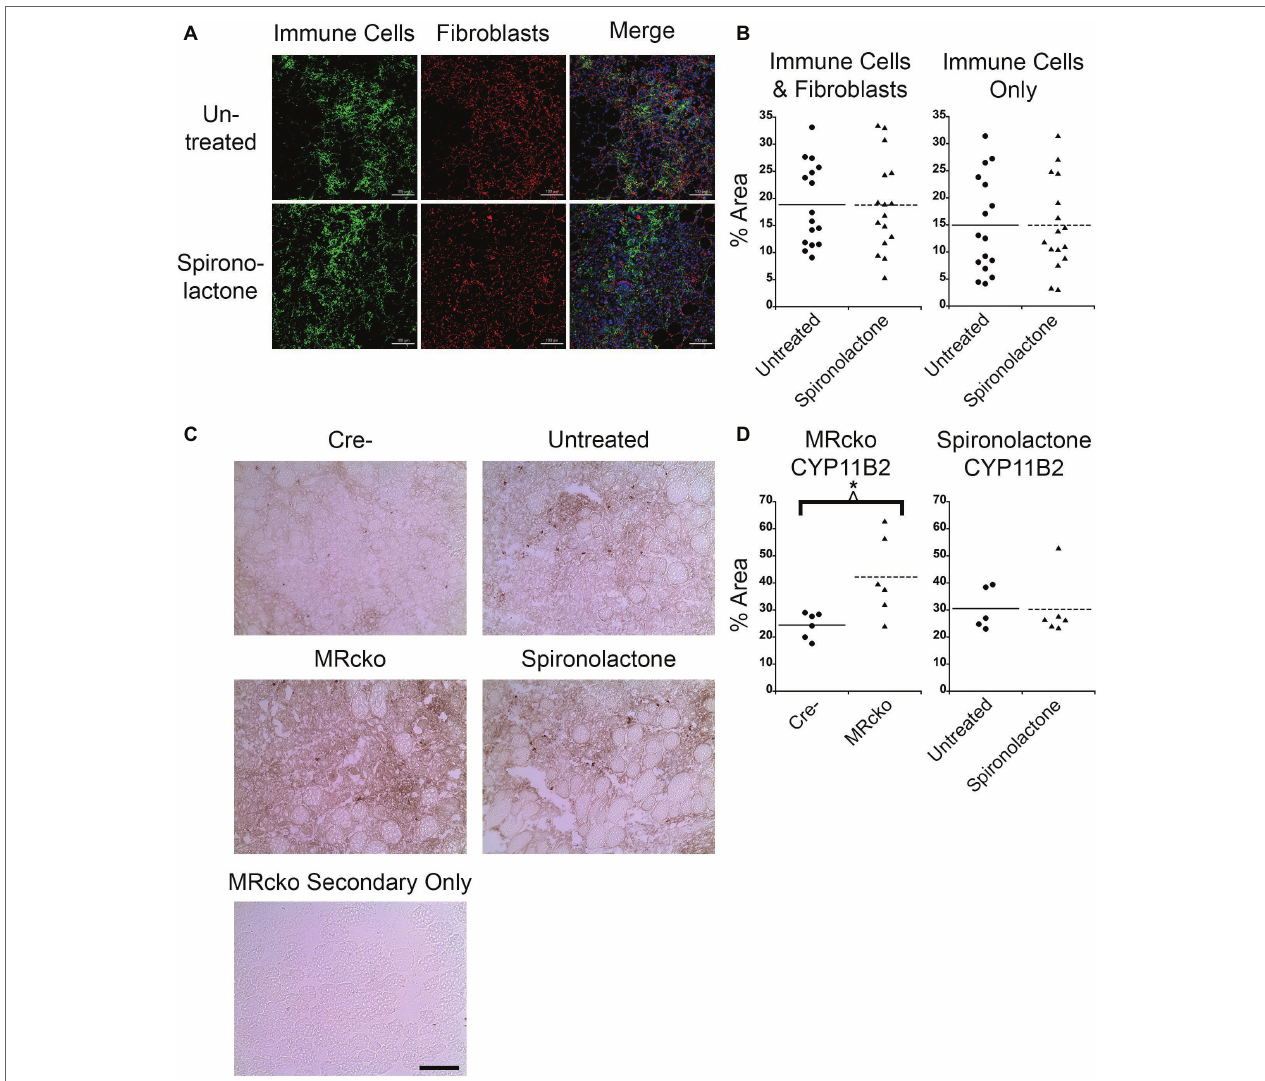
FIGURE 5 | MRcko mice have increased CYP11B2 infiltration at 4 days post-injury. (A) Acutely injured tibialis anterior (TA) muscles of spironolactone treated and untreated mice at 4 days after acute injury were stained for CD11b to visualize myeloid immune cells (green), vimentin to visualize fibroblasts (red), and with DAPI to visualize nuclei (blue in merged image) and were imaged with confocal microscopy. Zoomed out images are shown to depict the areas of muscle infiltrated by immune cells (green dots) or fibroblasts (red dots) quantified in B. Scale bar = 100 μ m. (B) Dot plots of spironolactone treated and untreated mouse ( n = 16 spironolactone, and 16 untreated) TA muscle percent area at 4 days post-injury of immune cells and fibroblast infiltration together or percentage of myeloid immune cells infiltration alone. Means are shown by lines for each group in the dot plots. (C) CYP11B2 immunohistochemistry was analyzed at 4 ( n = 6 Cre − , and 6 MRcko) ( n = 5 untreated, and 6 spironolactone) days post-injury. Scale bar = 100 μ m. (D) Dot plots of CYP11B2 percent infiltration at 4 days post-injury. Means are shown by lines for each group in the dot plots. All data was analyzed using a Student’s t -test. * p ≤